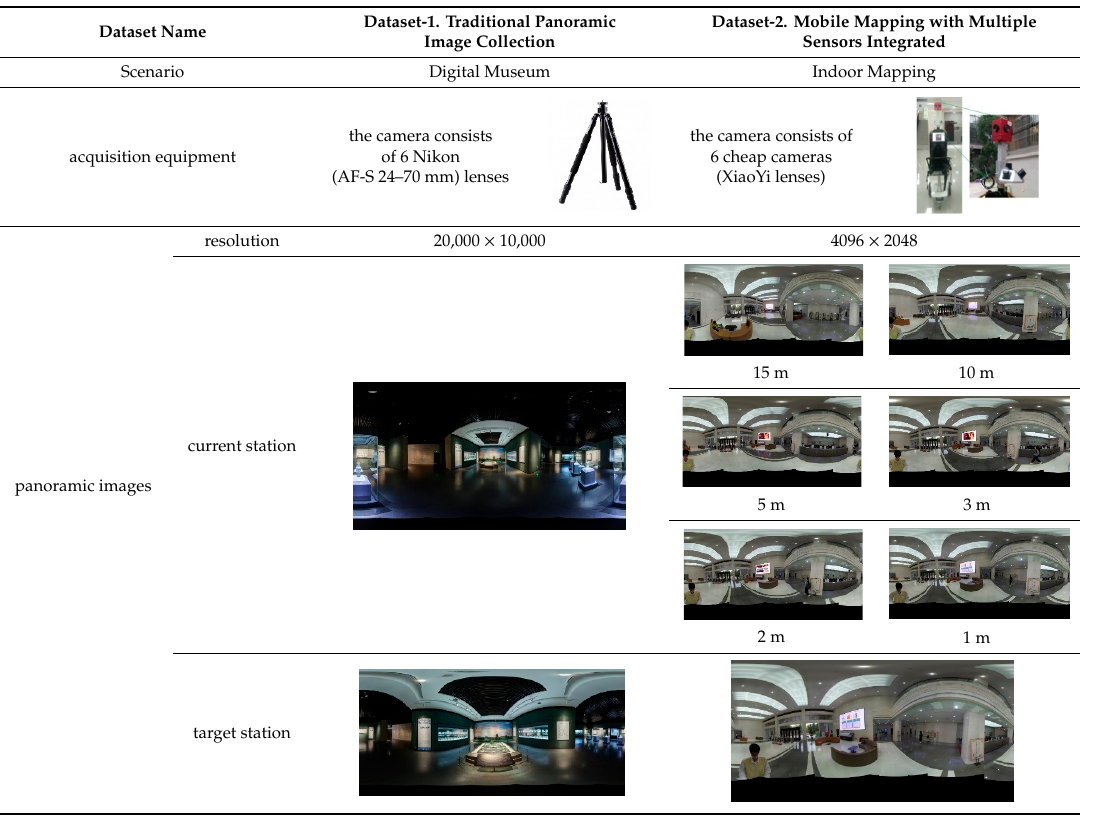
Table 1. Experimental datasets.